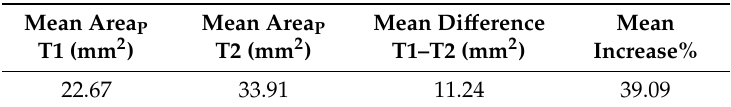
Table 6. Mean of the palatal areas calculated by using IMAGEJ at T1 (2 months) and T2 (4 months); the mean di ff erences between the size of the palatal areas at 2 and 4 months and their mean percentage